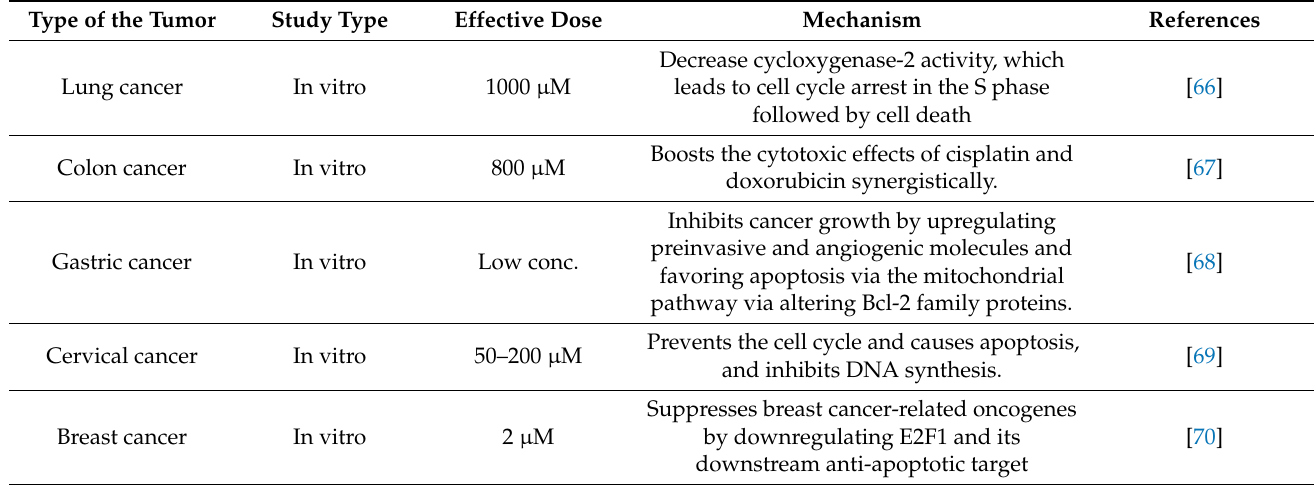
Table 3. Mechanisms of Eugenol for anti-apoptotic in various